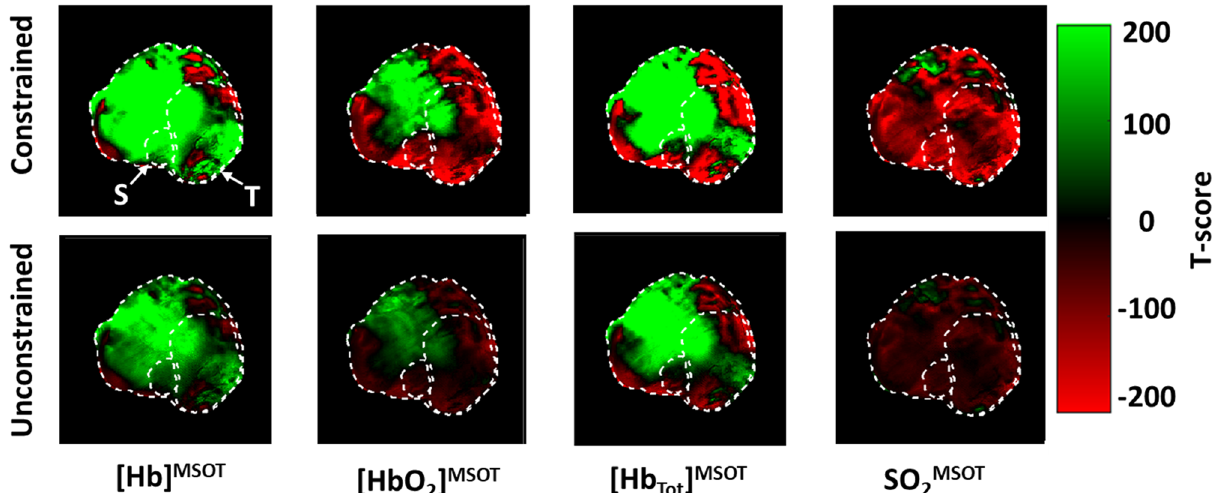
Figure 9. T-scores of difference in each parameter before and after CA4P administration in Dataset A. Across all channels, the constrained method results in T scores with substantially increased magnitude, corresponding to greater significance. The large positive region in the upper-left of the [Hb] MSOT , [HbO 2 ] MSOT , and [Hb tot ] MSOT is likely due to physiological effects unrelated to the local vascular effects of CA4P or the choice of processing. This effect is normalized in the ratiometric calculation of SO 2 MSOT . Figure created using a combination of MATLAB and Microsoft PowerPoint.